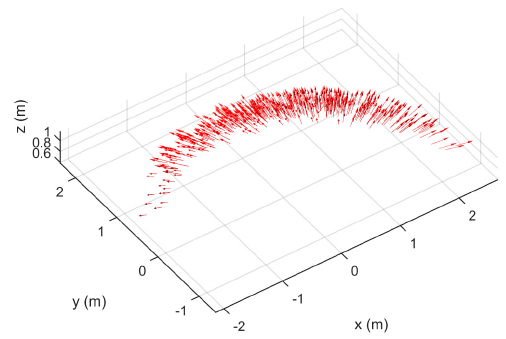
Figure 6. Velocity vector plot of particles expressed in spreader coordinate system. The spreader was set at configuration B. For reasons of clarity, only 10% of the particles are shown.